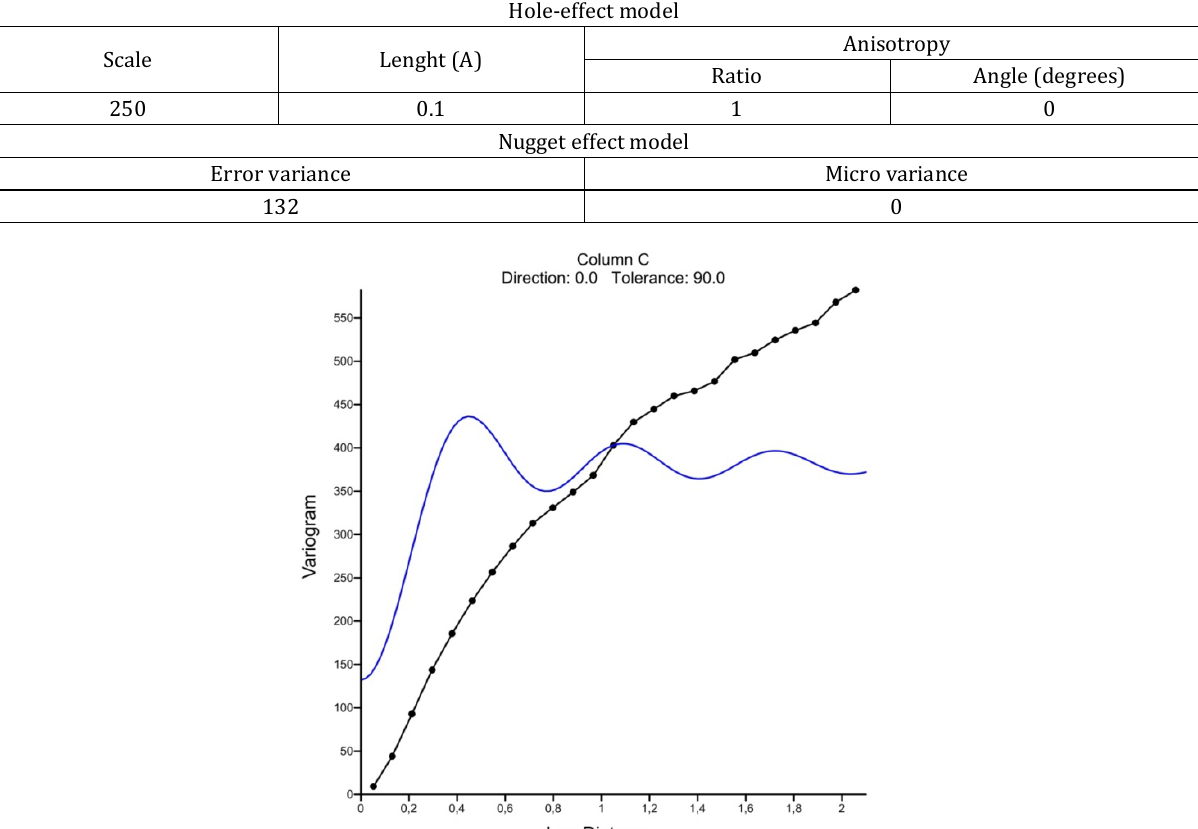
Fig. 4. The empirical variogram along with a „hole-effect” model and a „nugget effect” model, both deliberately unadjusted with it (blue line – theoretical model)